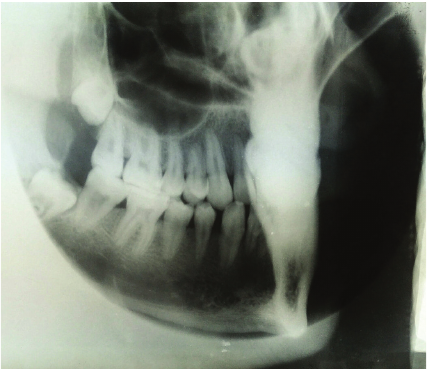
Figure 1: Preoperative lateral radiography of right side mandibular wisdom tooth.